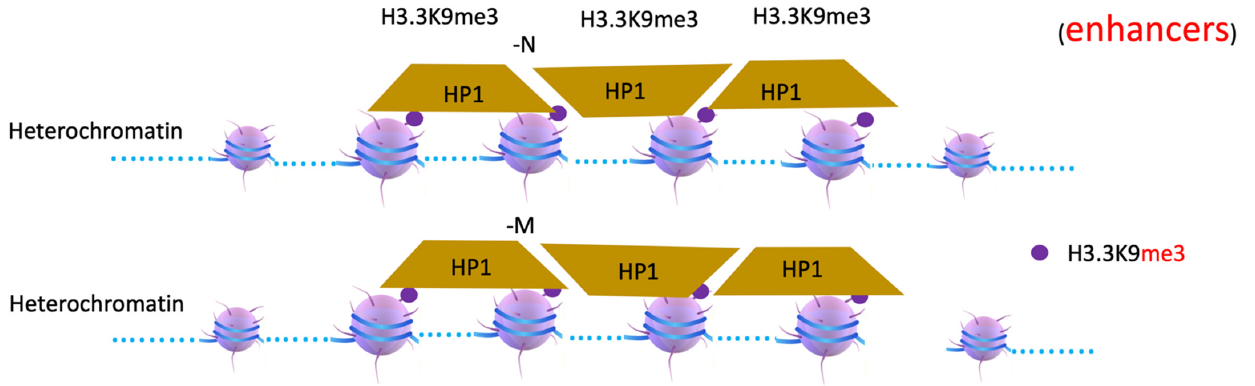
Figure 8. A model of how heterochromatin is formed by HP1 after methylation of H3K9.